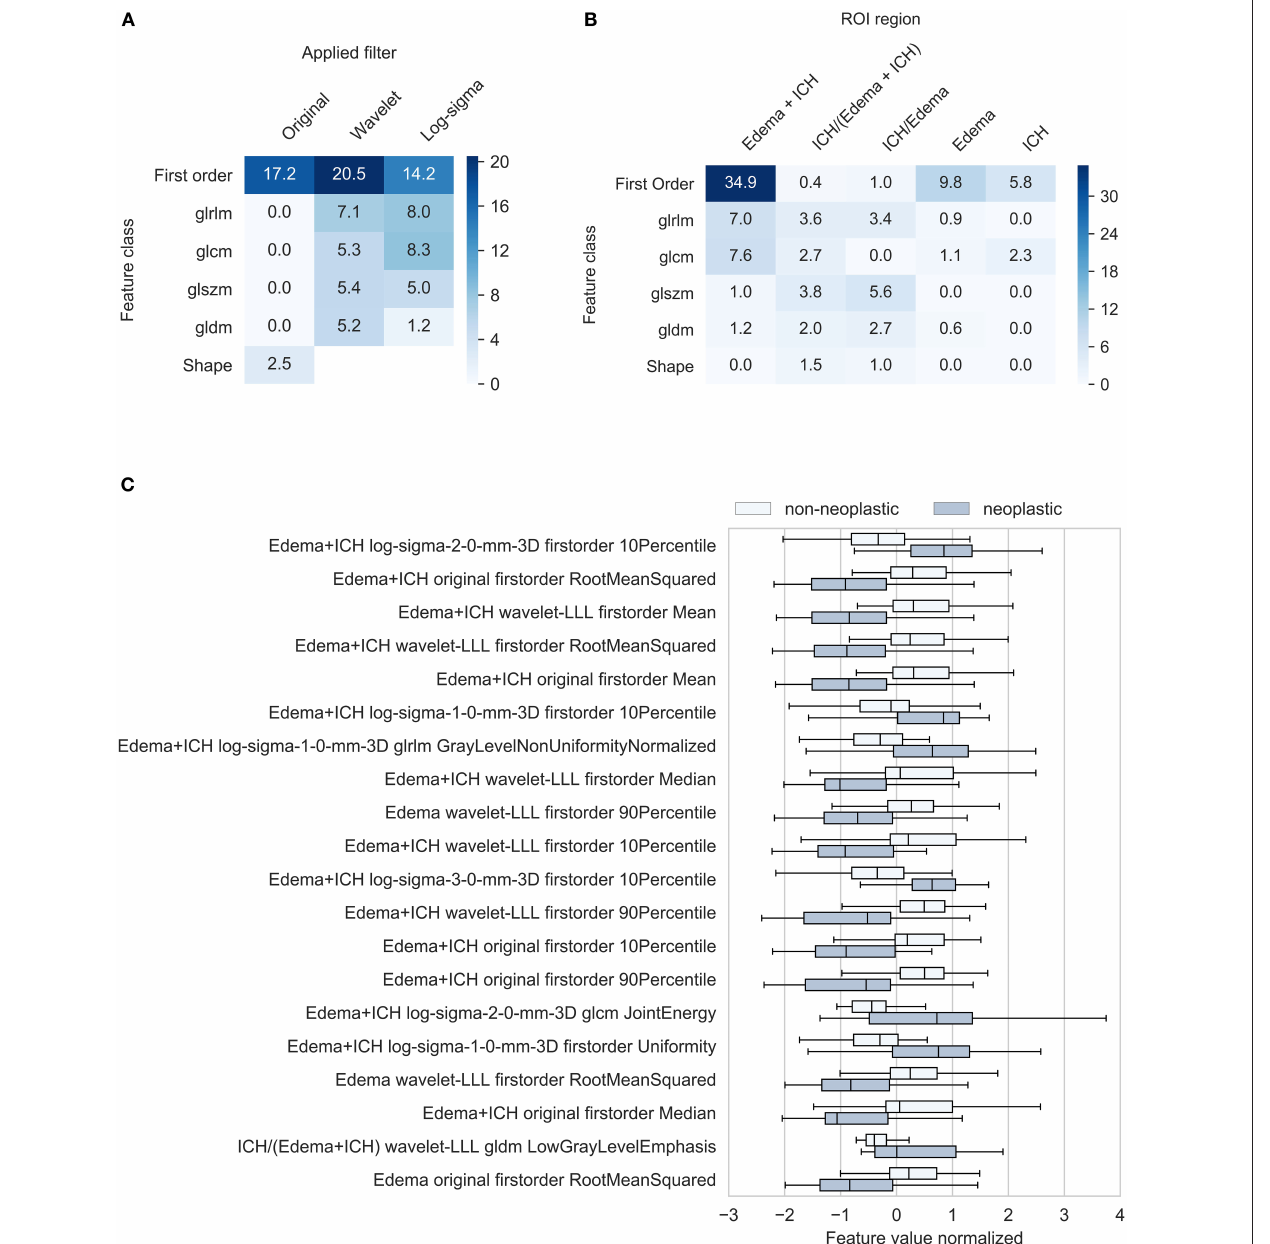
FIGURE 3 | Characterization of most important features. Feature importance contribution of 100 most important features in % (A) By applied filter and feature class (B) by region and feature class. Texture feature class includes gray level size zone matrix, gray level dependence matrix, gray level run length matrix, and gray level size zone. (C) Radiomic feature signatures of neoplastic and non-neoplastic intracerebral hemorrhage. Box-plots show normalized means of the 20 most important image features. All mean feature values significantly different between neoplastic and non-neoplastic ICHs ( P < 0.05). ROI, region of interest; ICH, intracerebral hemorrhage; PHE, perihematomal edema; gldm, gray level dependence matrix; H, high-pass wavelet decomposition; L, low-pass wavelet decomposition; glnu-norm, gray level non-uniformity normalized; RMS, root mean